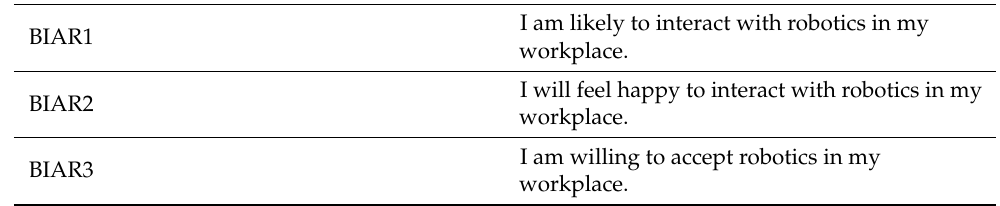
Table A1. Cont. Behavioral Intention to accept robotics at workplace BIAR1 BIAR2 BIAR3